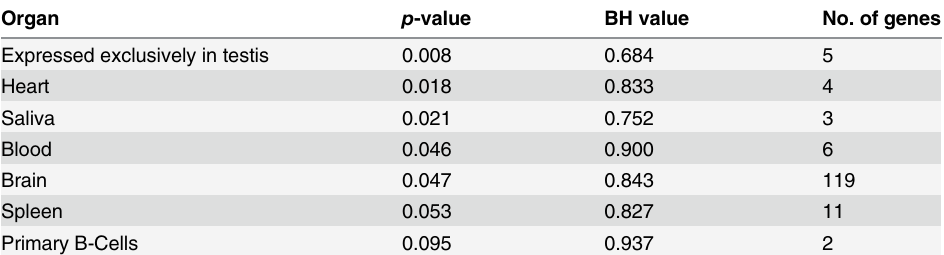
Table 2. Tissue-specific genes uniquely expressed in the AFS.